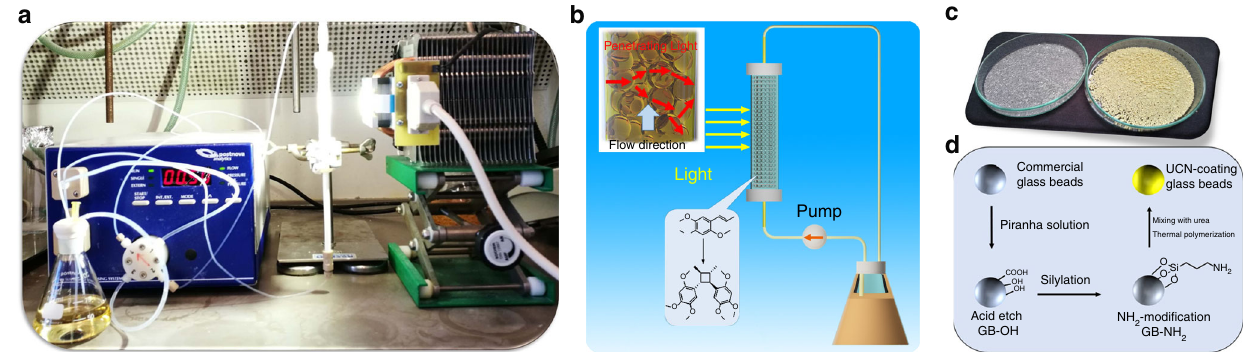
Fig. 3 The construction of the fi xed-bed photoreactor. a Photograph of the fl ow-continuous photoreactor. b Scheme of fi xed-bed photoreactor fi lled with supported carbon nitrides for magnosalin production. c Commercial glass beads (left) and UCN-coated glass beads (right). d General process for UCN coating on the surface of glass beads.